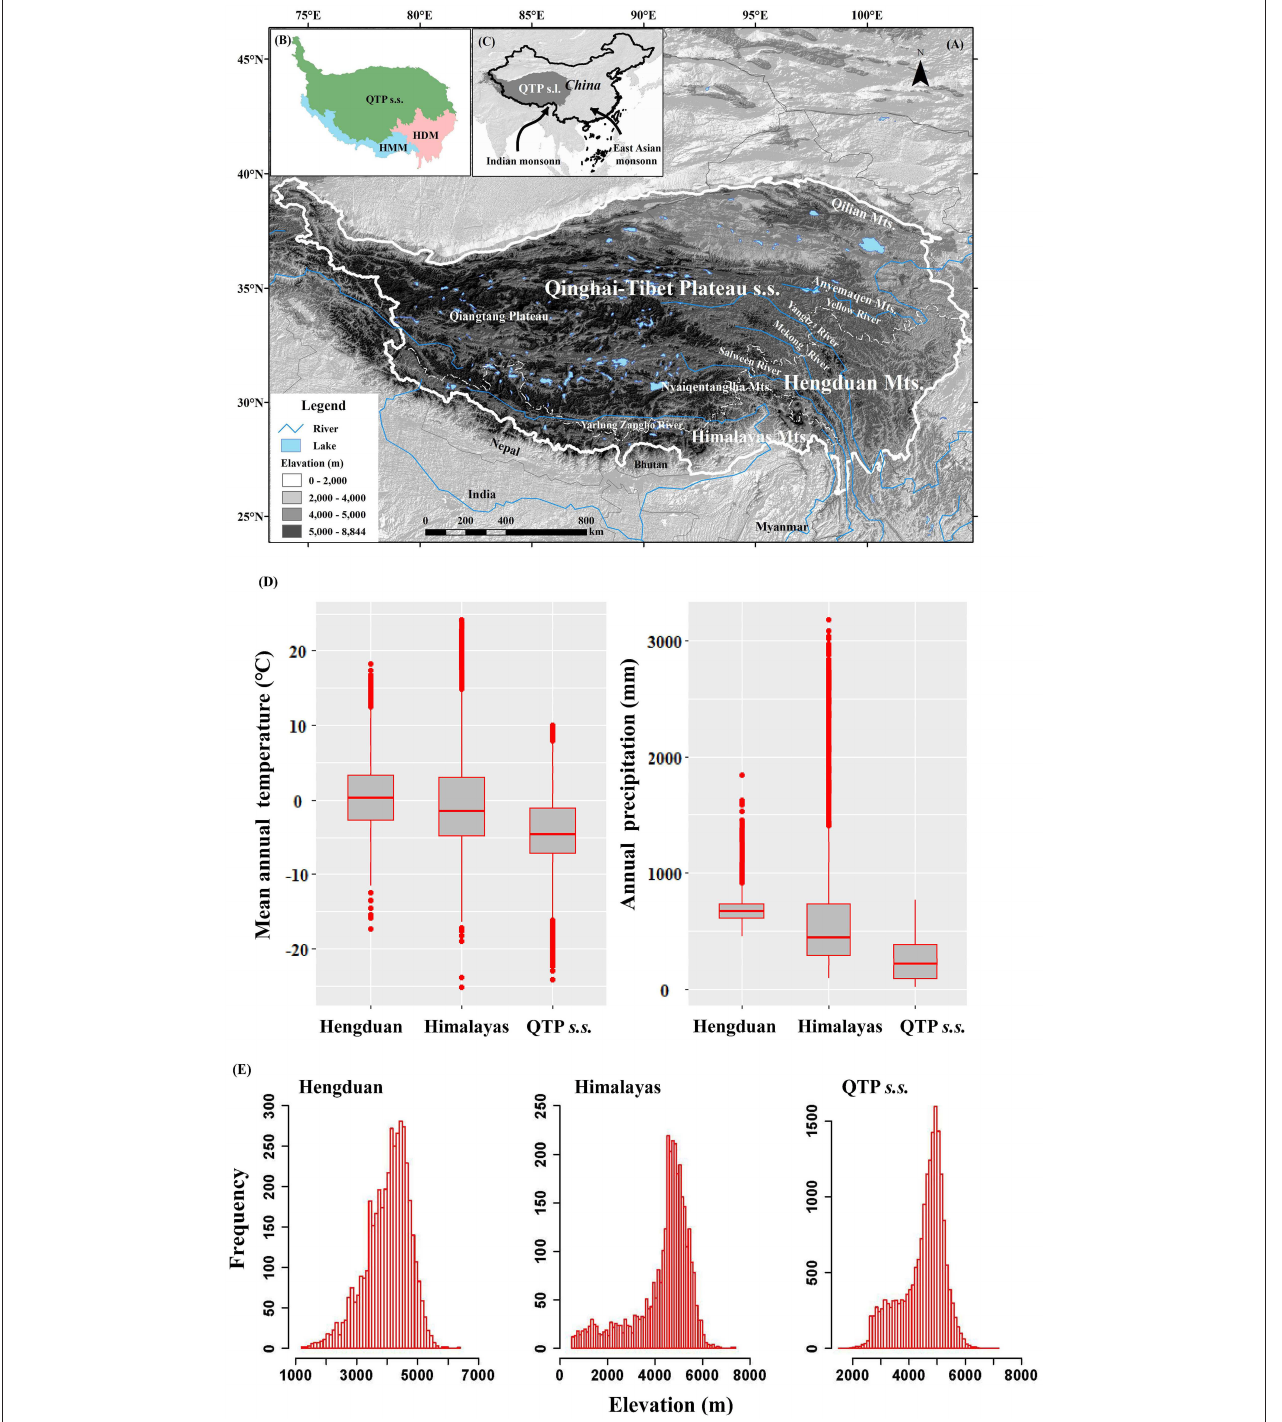
FIGURE 1 | The approximate boundary of the region of the Qinghai-Tibet Plateau in China and corresponding environmental conditions. (A) geographical area of the Qinghai-Tibet Plateau s.l. and its direct surrounding. (B) the Qinghai-Tibet Plateau s.l. contains three major regions, including the Hengduan Mountains (HDM), the Himalayas (HMM), and the Qinghai-Tibet Plateau s.s. (QTP s.s. ). (C) each summer, this plateau is profoundly influenced by the Indian and East Asian monsoons. (D) the distributions of annual mean temperature and annual precipitation in the Hengduan Mountains, the Himalayas and the Qinghai-Tibet Plateau s.s. . (E) the histograms of elevation in the Hengduan Mountains, the Himalayas, and the Qinghai-Tibet Plateau s.s. . The boundary of the Qinghai-Tibet Plateau s.l. refers to Zhang et al. (2002), and the scopes of these three typical regions refer to Körner et al. (2017), Xing and Ree (2017), and Liang et al. (2018).